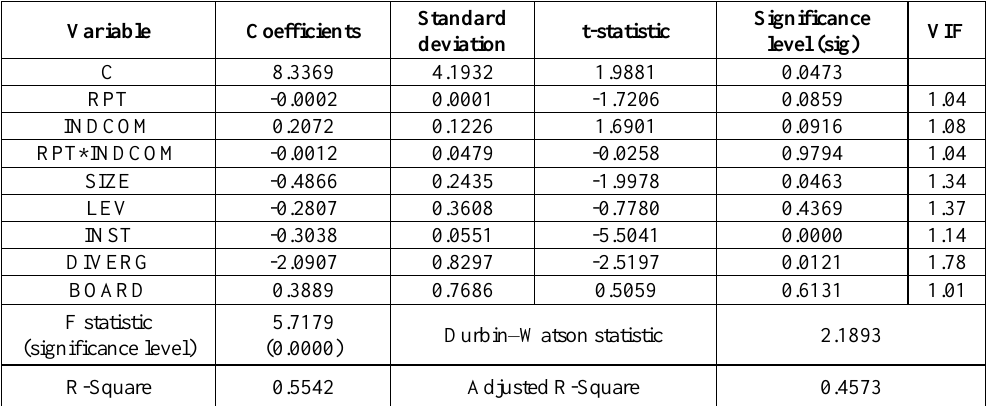
Table 4. The results of the first model test (Tobin's Q is the dependent